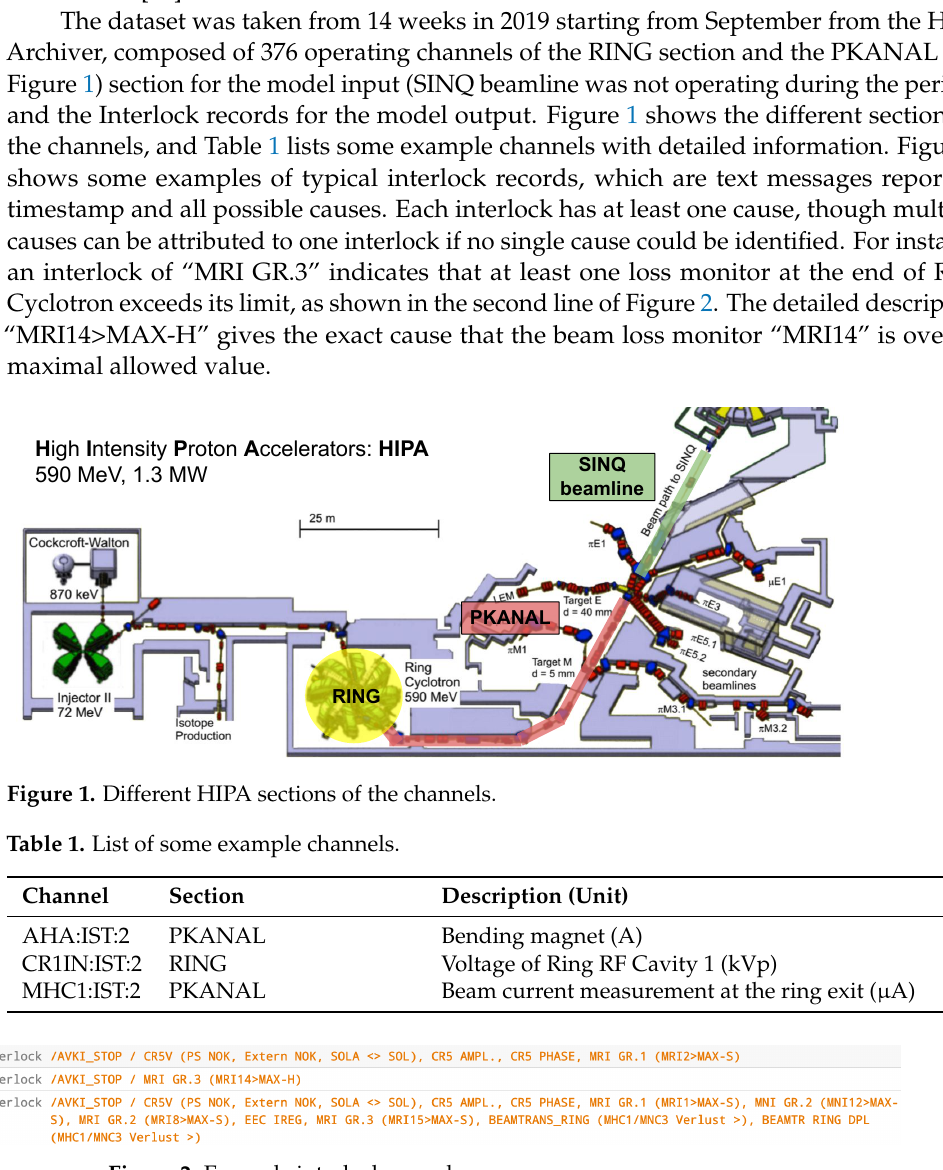
Figure 2. Example interlock record messages.